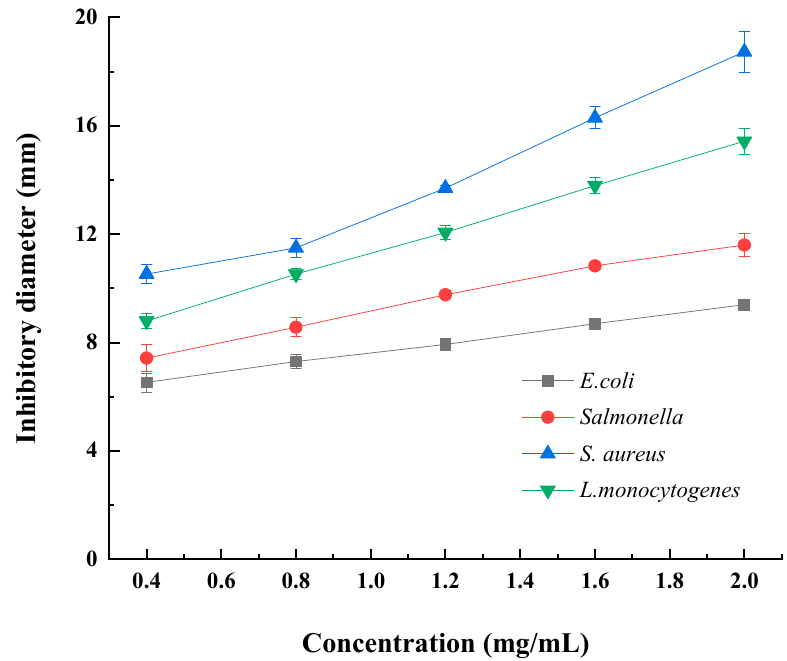
Figure 5. The agar disc diffusion test was applied to assess the antimicrobial activity of DLP-3. At the same time, the MIC of DLP-3 against E. coli , salmonella , S. aureus, and L.mono- cytogenes was also investigated to evaluate the antibacterial activity of DLP-3. The results presented that the MICs of DLP-3 against E. coli , salmonella , S. aureus, and L.monocytogenes were 1.6, 1.0, 0.2, and 0.6 mg/mL, respectively. All of these suggest that DLP-3 could be considered to be a potential alternative antibacterial agent to currently used antibiotics. Hajji et al. (2018) [51] reported that the MICs of polysaccharides isolated from Periploca laevigata root barks (PLP1) against E. coli , S. aureus, and L. monocytogenes were 0.5 mg/mL, 0.3 mg/mL, and 0.8 mg/mL, respectively. Kungel et al. (2018) [46] reported that the MICs of polysaccharides isolated from yerba mate (Ilex paraguariensis) (YM polysaccharide) against E. coli and S. aureus were 1.6 mg/mL and 0.6 mg/mL, respectively. In this study, DLP-3 showed lower MICs against S. aureus and L. monocytogenes than PLP1 and lower MICs against E. coli and S. aureus than YM. Polysaccharides may become a barrier to in- hibit the growth of bacterial cells by preventing the intake of nutrients [52]. In addition, high concentrations of polysaccharides can also increase cell permeability and structural damage by destroying the inner membrane, releasing electrolytes and other cellular com- ponents, and leading to bacterial cell death [48]. 2.4. Anticancer Activity of DLP-3 The anticancer effect of DLP-3 against the HepG2 is illustrated in Figure 6. DLP-3 could inhibit the proliferation of HepG2 in a concentration-dependent manner. The results of the MTT assay indicated that the proliferation of HepG2 cells treated with DLP-3 was significantly inhibited (Figure 6A). The MTT results indicated that HepG2 cells were more susceptible to DLP-3 at 72 h. In the colony formation assay, HepG2 cells treated with DLP-3 (0.2, 0.4, and 0.8 mg/mL) formed fewer colonies than the untreated control group, a phenomenon that was concentration dependent (Figure 6B,C). The results indicated DLP-3 could effectively slow down the clonogenic of HepG2.